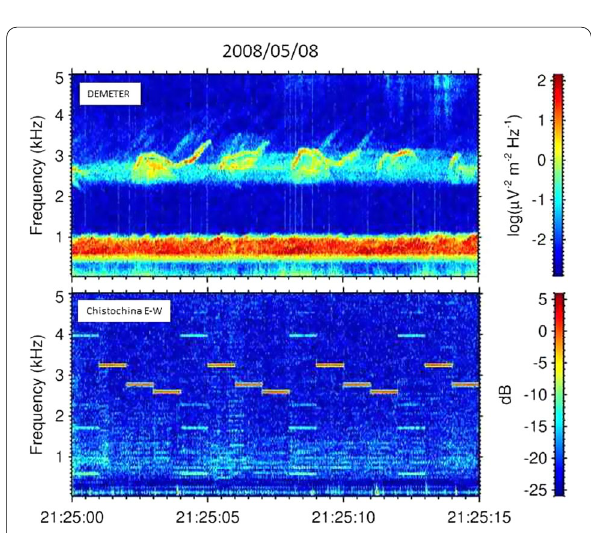
Fig. 14 Zoom of Fig. 12. Comparison between the spectrograms recorded by DEMETER in the Northern hemisphere (top panel), and recorded at Chistochina (bottom panel). The power spectral density is color-coded according to the scale on the right